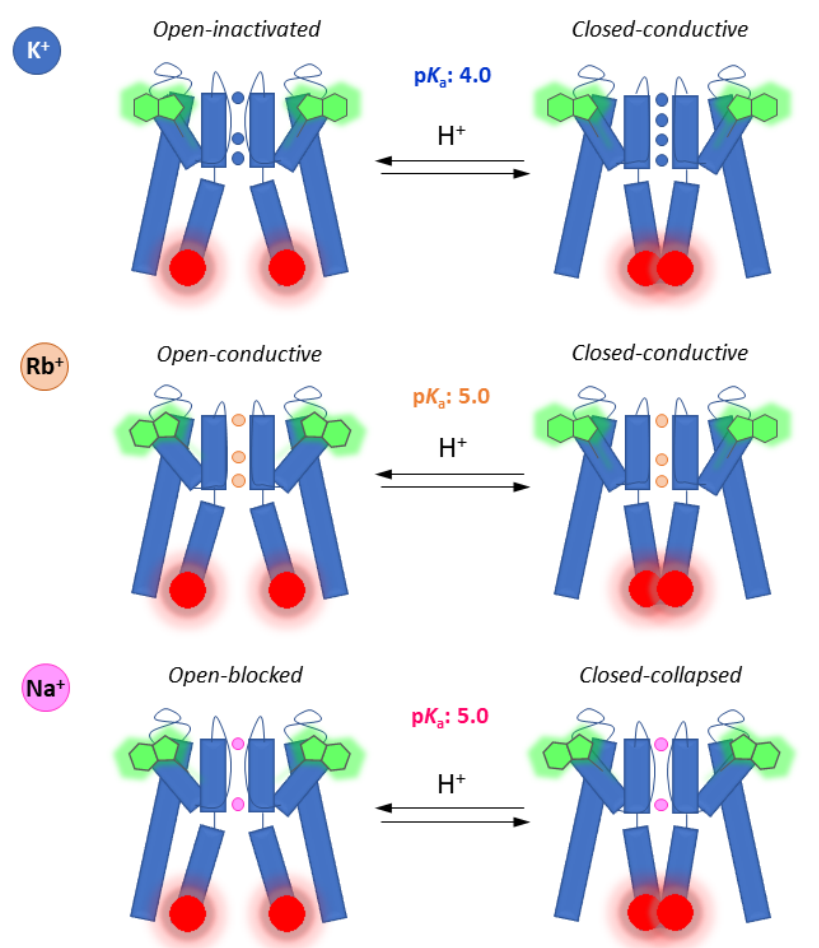
Figure 8. The ion occupancy at the S2 site of the SF contributes to controlling the allosteric crosstalk between the inner and outer gates of the KcsA potassium channel. Schematic representation of the allosteric communication between the inner and outer gates of the KcsA channel, reported by fluorescence anisotropy of the covalently bound TMR at position C116 (red) and the intrinsic fluorophore W67 (green), respectively. The conformation of the SF (outer gate) is sensitive to the different ion occupancy presented by K + , Rb + and Na + . In the case of K + , its ability to bind with equal probability to the four binding sites at the SF (when the inner gate is in the closed conformation) leads to closer W67-W67 inter-subunit distances and an activation p K a of ∼ 4.0. On the other hand, the inner gate opened at lower [H + ] (pK a of ∼ 5.0) when Rb + or Na + are bound to the SF at S1–S3–S4 or S1–S4 positions, respectively, i.e., when there was a loss of ion occupancy at the S2 site. The inability of both cations to interact with the S2 site at the outer gate is also characterized by higher W67-W67 inter-subunit distances.